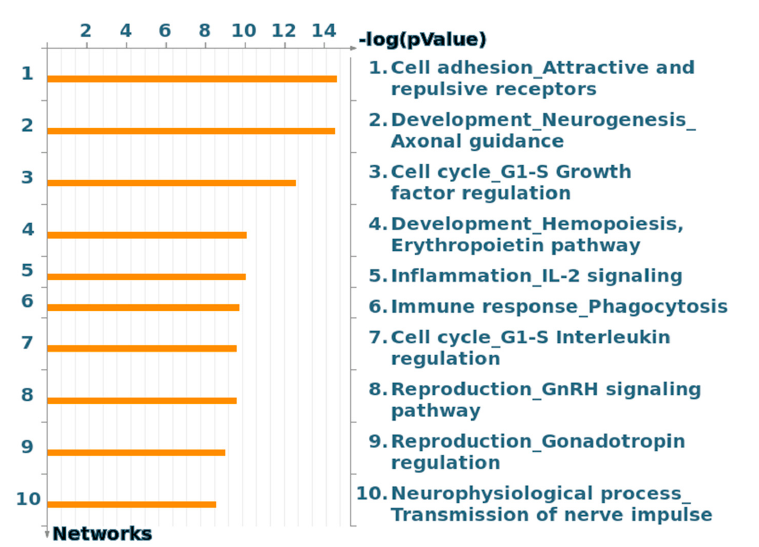
Figure 2. Top 10 process networks based on data obtained from the kinase activity measurements on PamChip.